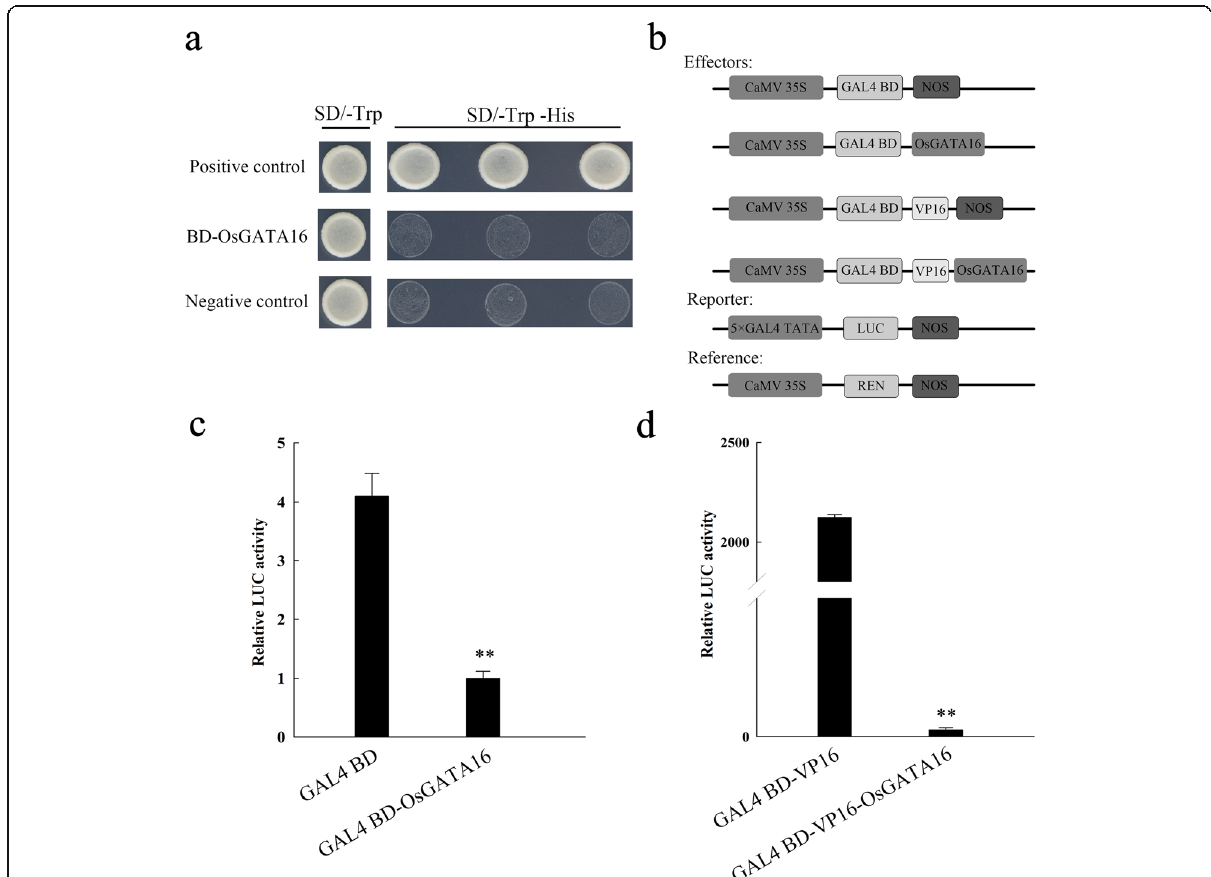
Fig. 5. Transcriptional activity of OsGATA16 in rice. a Yeast two-hybrid analysis of OsGATA16 transcriptional activity. b Schematic representation of recombinant effector, reporter, and reference (pPTRL) plasmids for Dual-luciferase reporter analysis. c-d Relative LUC activity with control and OsGATA16 effector constructs. Data represent the mean ± SE from three replicates. Asterisks indicate significant differences in relative LUC activity (Student ’ s t-test, ** p <